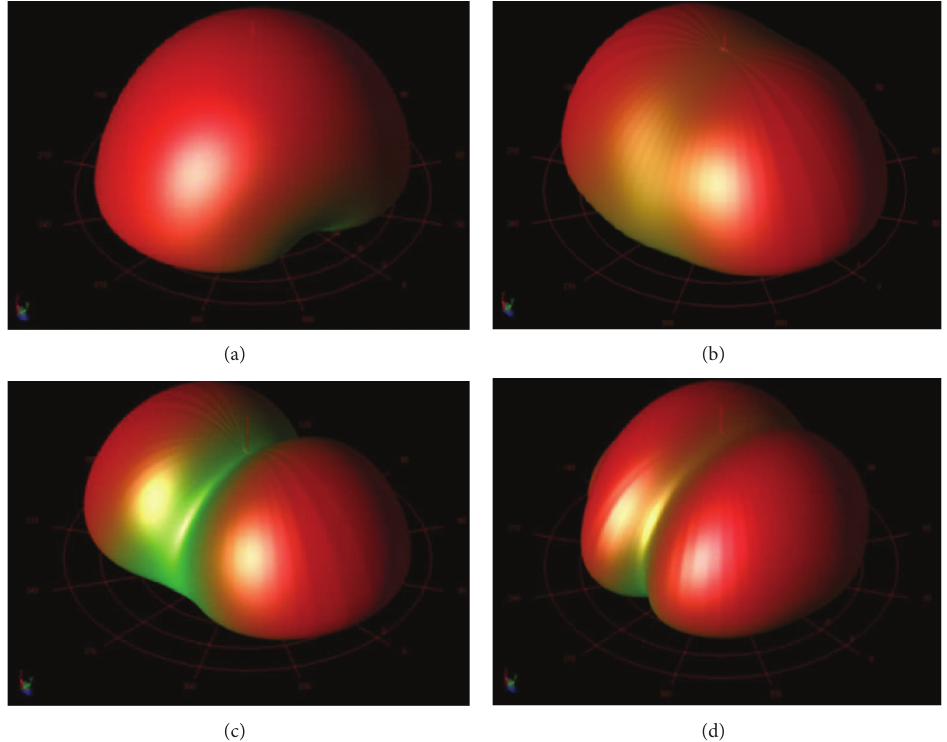
Figure 14: Simulated three-dimensional (3D) radiation gain patterns of the proposed antenna composed of six unit cells in elevation plane ( Φ = 0 ∘ ) and at operation frequencies: (a) at 4.3GHz, (b) at 6GHz, (c) at 9GHz, (d) at